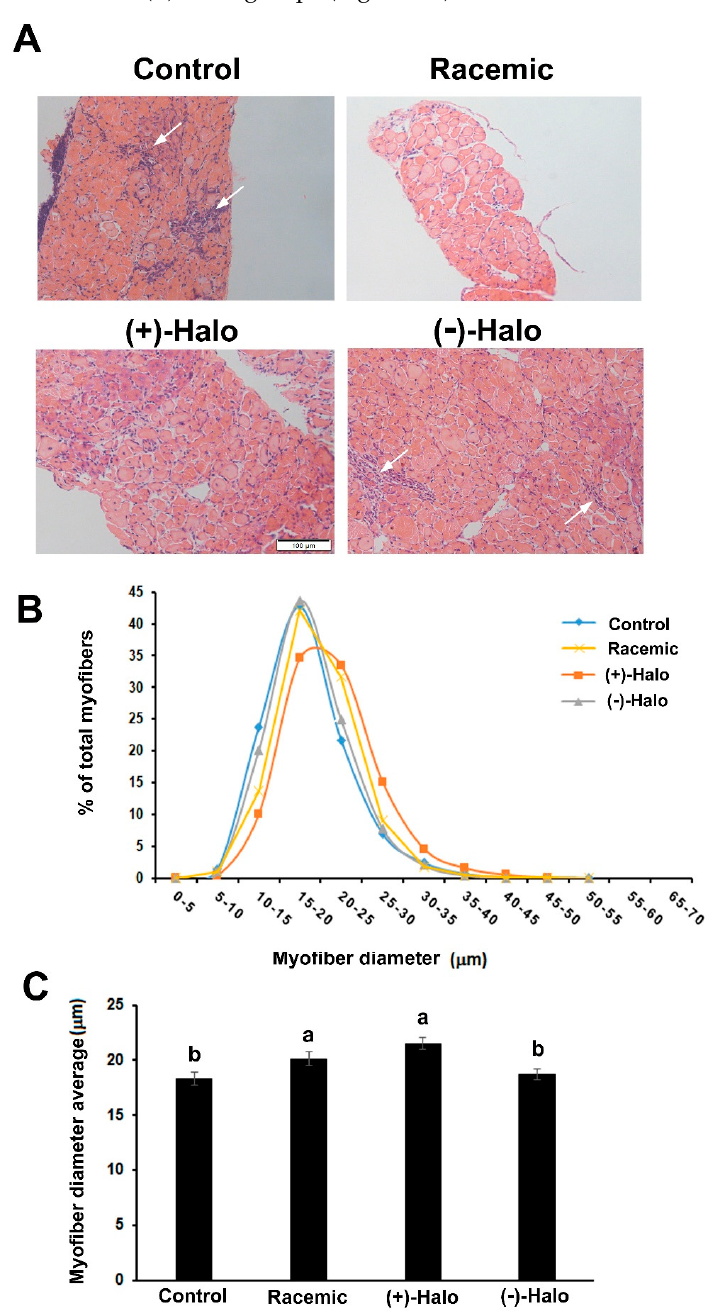
Figure 4. Effect of the halofuginone enantiomers and their racemic combination on the histopathology of mdx diaphragms. The experimental course was as described in Figure 3. ( A ) Hematoxylin and eosin (H&E) staining of diaphragms derived from the treated mice at 14 weeks of age. Fewer degeneration areas (white arrows) are observed in the Racemic and (+)-halofuginone enantiomer [(+)-Halo] sections with a more unformed appearance of the myofibers. Bar, 100 µ m. ( B ) Distribution of myofiber diameters in mdx diaphragms. Myofibers were clustered in bin intervals of 0.5 µ m, and data are presented as percentage of total myofibers. Between 4000 to 4700 myofibers were counted for each treatment group. ( C ) Quantitation analysis the average of myofiber diameter of the experimental groups, presented as mean ± SE ( n = 4). Bars with different letters indicate significant difference between treatments ( p <